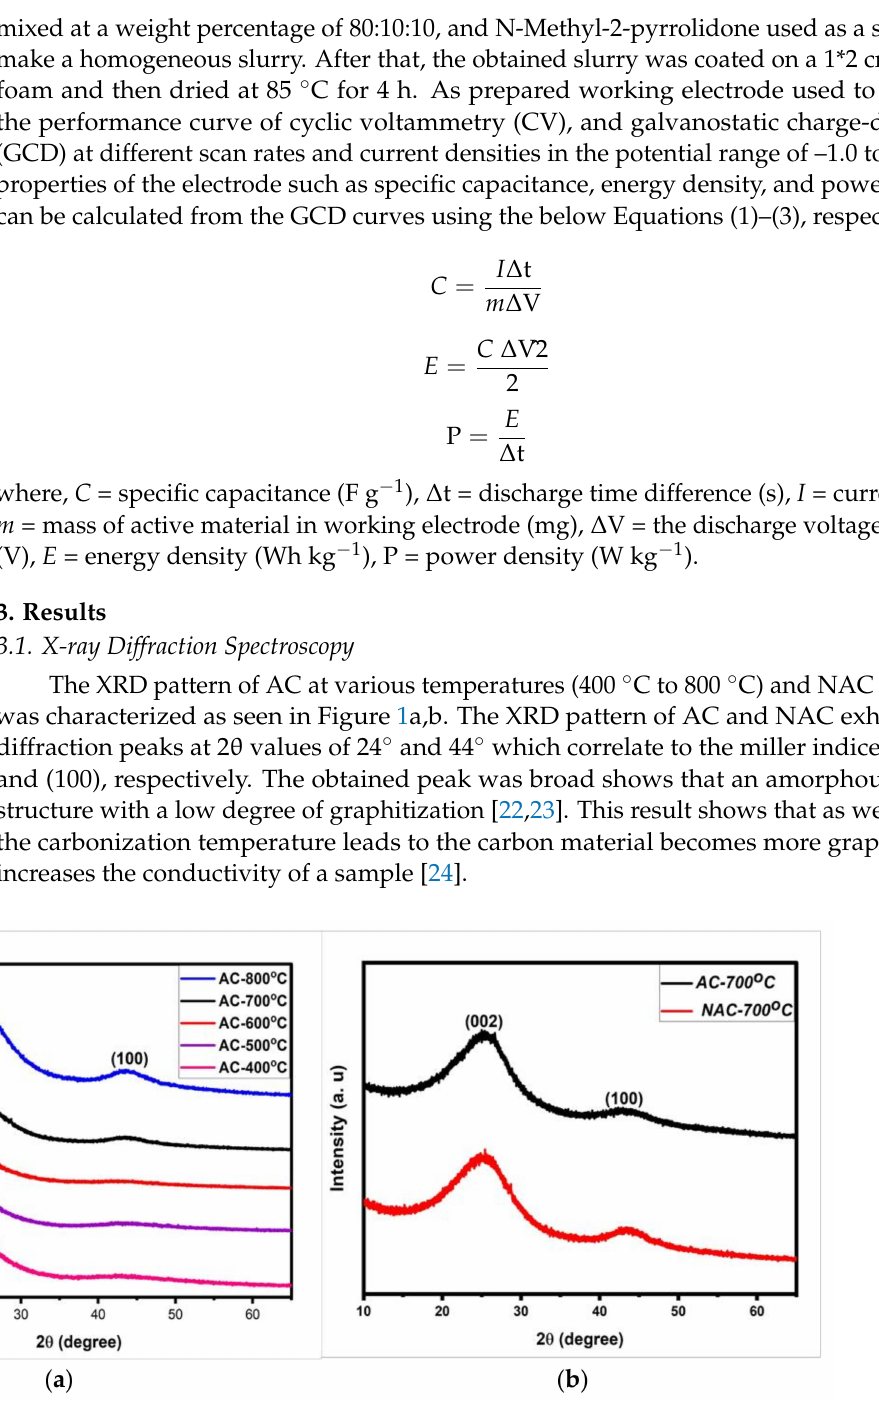
Figure 1. XRD pattern of ( a ) various temperature AC ( b ) AC-700 ◦ C and NAC-700 ◦